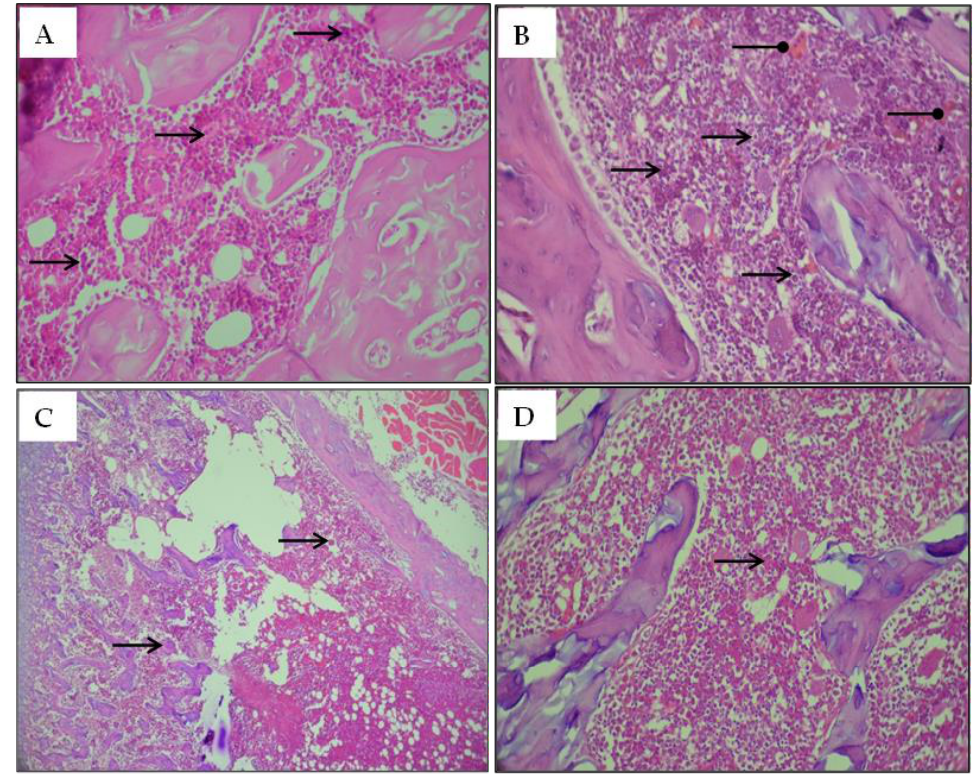
Figure 6. Optical microscopy histological sections of the bone marrow stained with hematoxylin-eosin (H&E) of adult rats. ( A ) Controls group; ( B ) Rats treated with MT; ( C ) Rats treated with MT + FRE and ( D ) Rats treated with FRE; Arrows indicate the following: : Megakaryocytic cell; : Apoptosis.